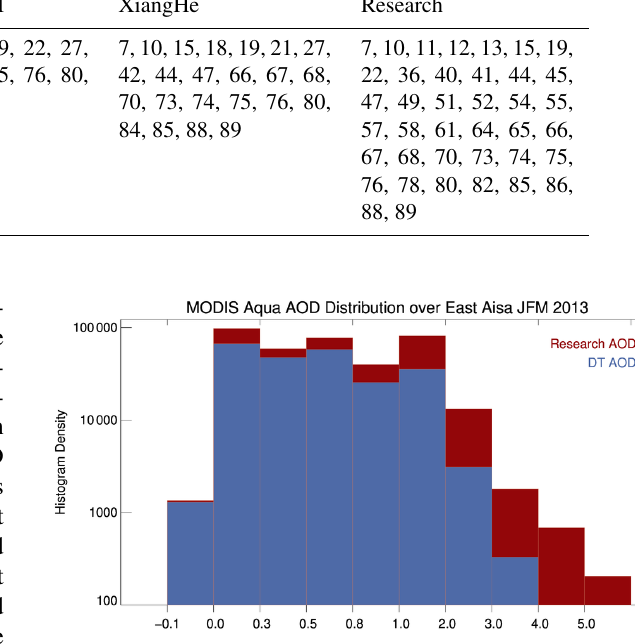
Figure 12. The histogram of MODIS AOD over the study region from January to March 2013 in a logarithmic scale. The red is the research AOD; the blue is the operational